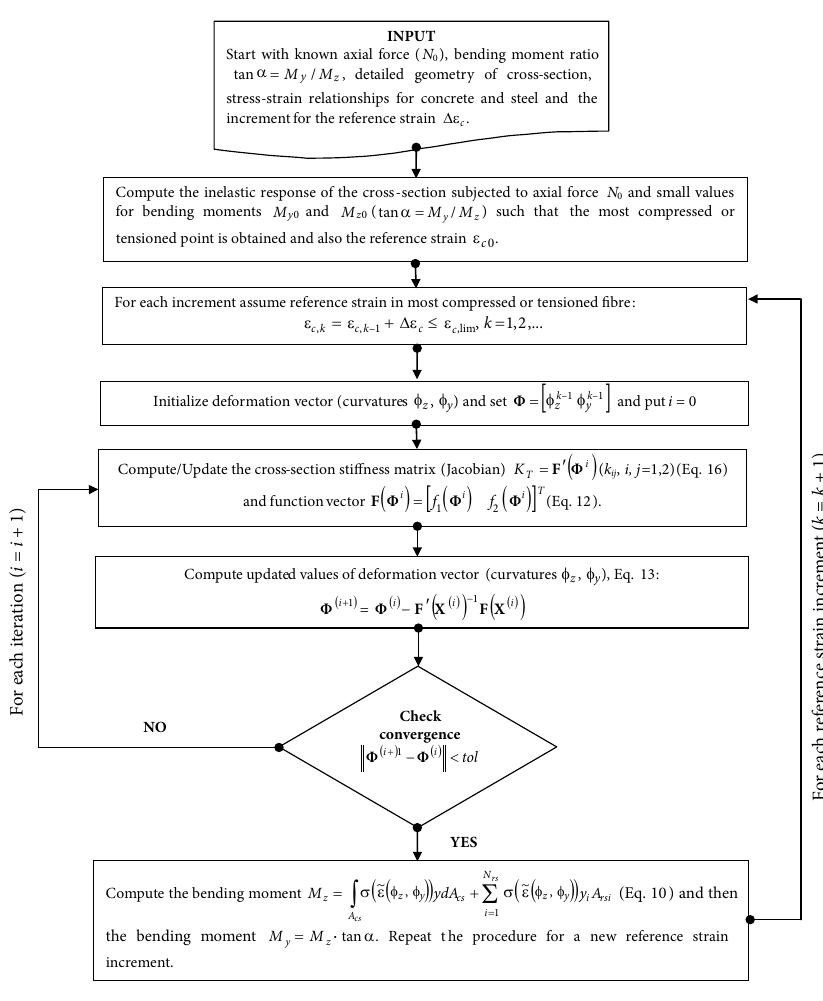
Fig. 4. Simplified analysis flowchart of the proposed